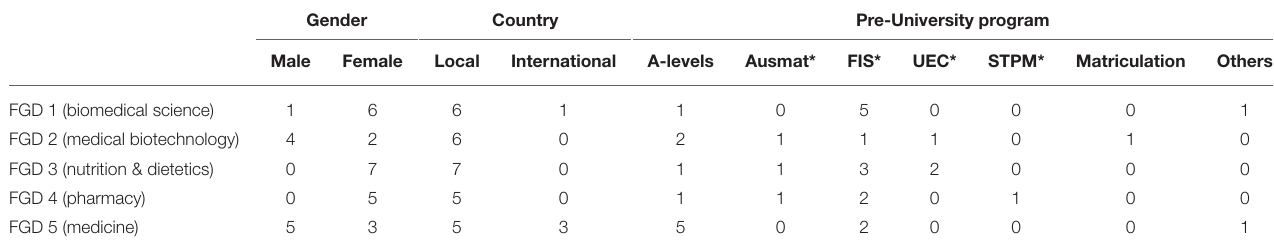
TABLE 1 | Demographics of the participants. Gender Country Pre-University program Male Female Local International A-levels Ausmat* STPM* Matriculation Others